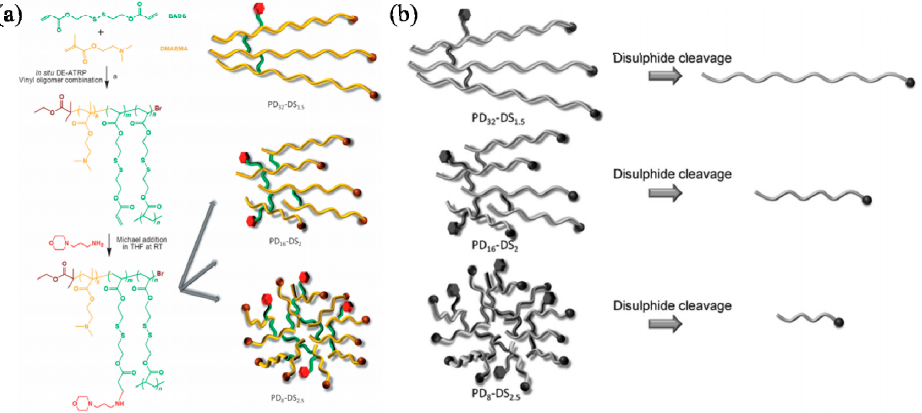
Figure 6. ( a ) (Left) Controlled radical cross-linking copolymerization through in situ DE-ATRP, followed by a post-functionalization process; and (Right) graphical representation of structures with different degrees of branching. The efficacy of functionalization depends on the content of the pendent vinyl groups; ( b ) Graphical representation of the degradation of structures with different degrees of branching. Copyright 2014, Wiley-VCH.